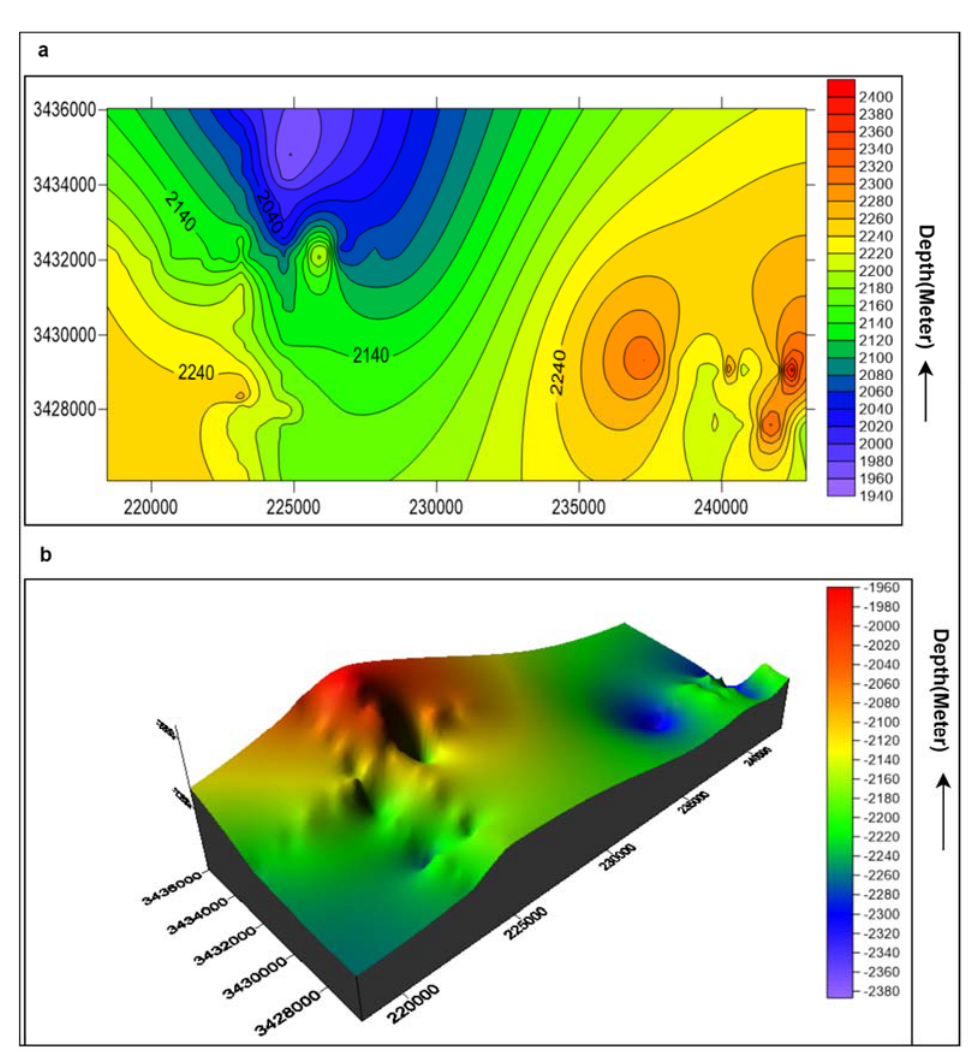
Figure 15. ( a ) Depth contour map of the Warcha formation. ( b ) Depth surface map of the Warcha formation. Figure 15. ( a ). Depth contour map of the Warcha formation. ( b ). Depth surface map of the Warcha formation.